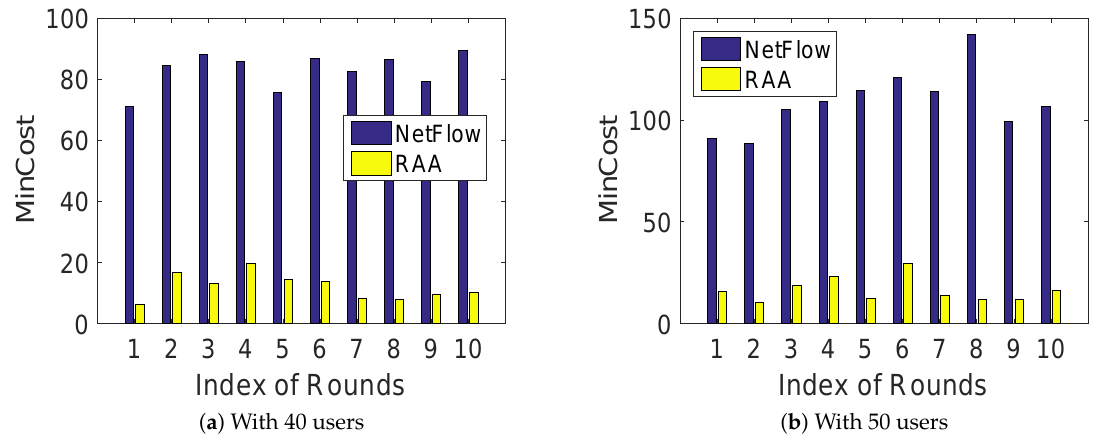
Figure 2. MinCost comparison for 10